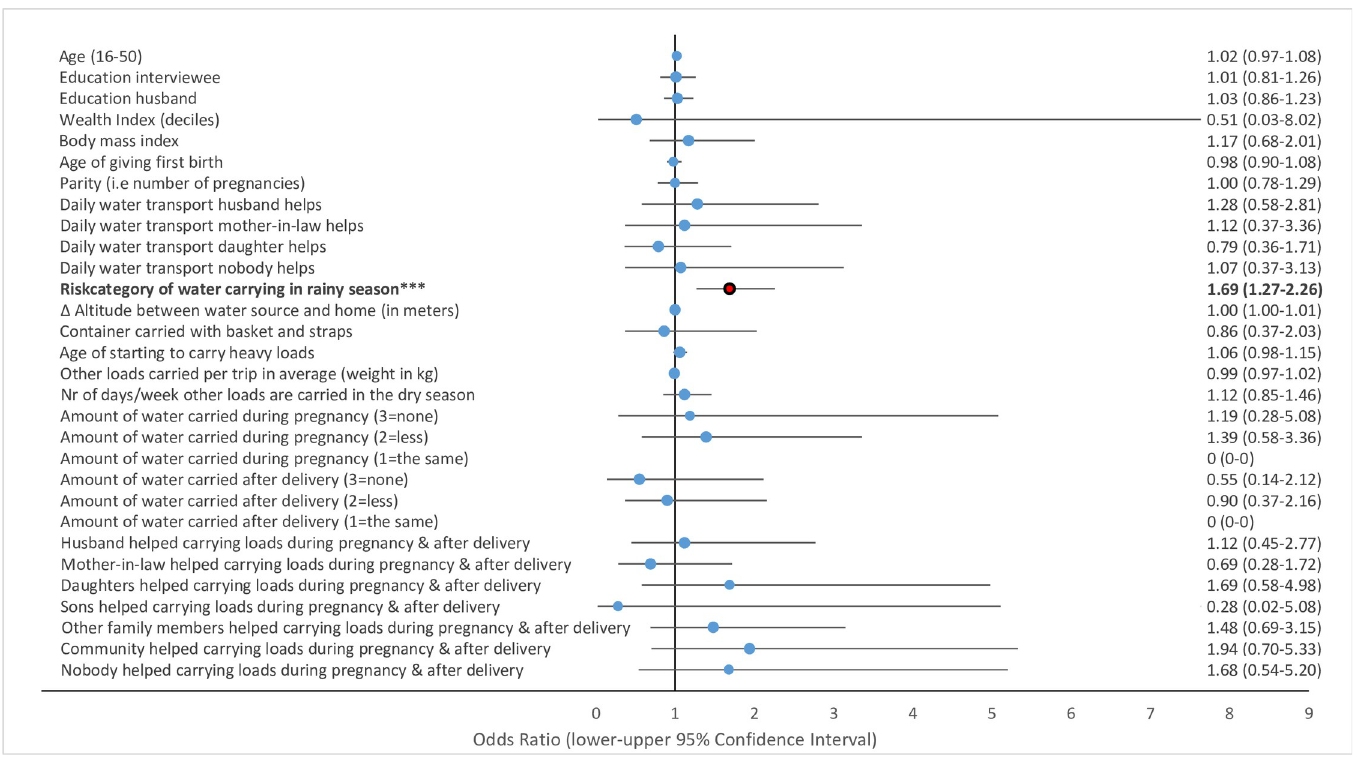
Fig 5. Association of risk factors with uterine prolapse in multivariate GLMM. ( ��� = significant at the p < 0.001-level, �� = significant at the p = 0.01-level, � = significant at the p = 0.05-level; = odds ratio statistically non-significiant, ... = odds ratio statistically significant).